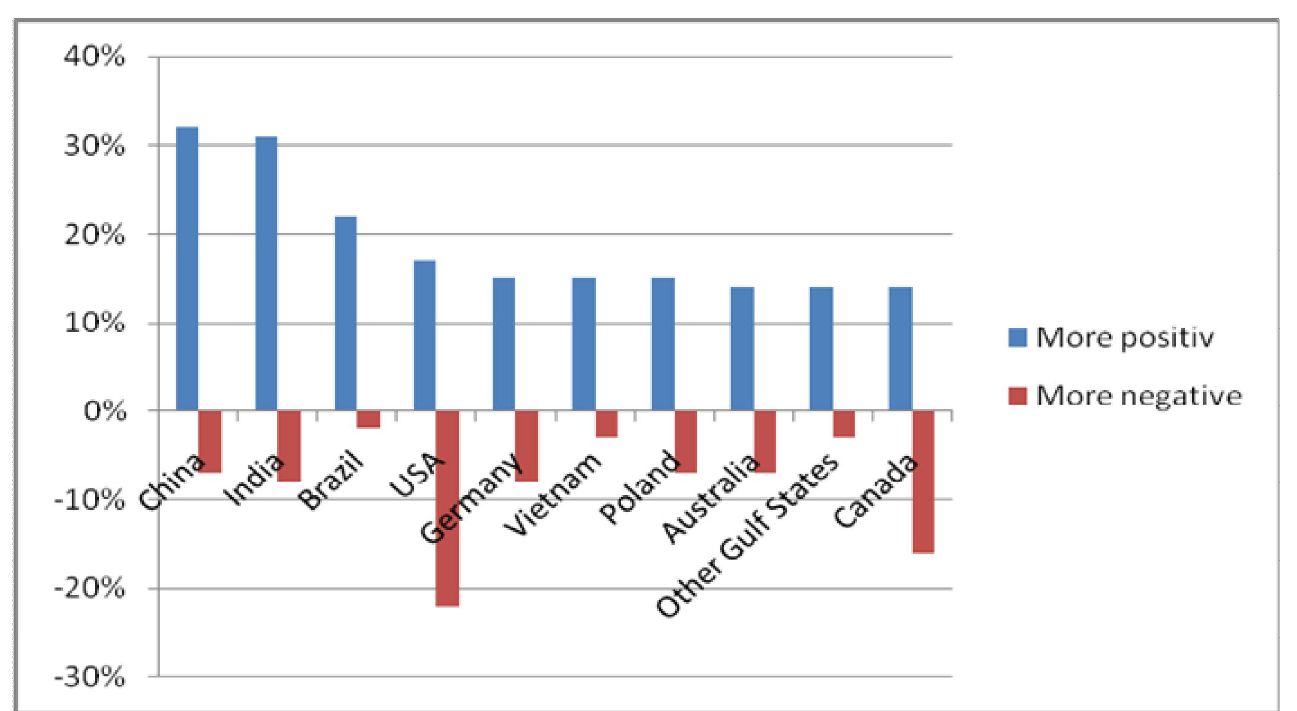
Figure 2 - Change in investor outlook compared to 2007 Source: